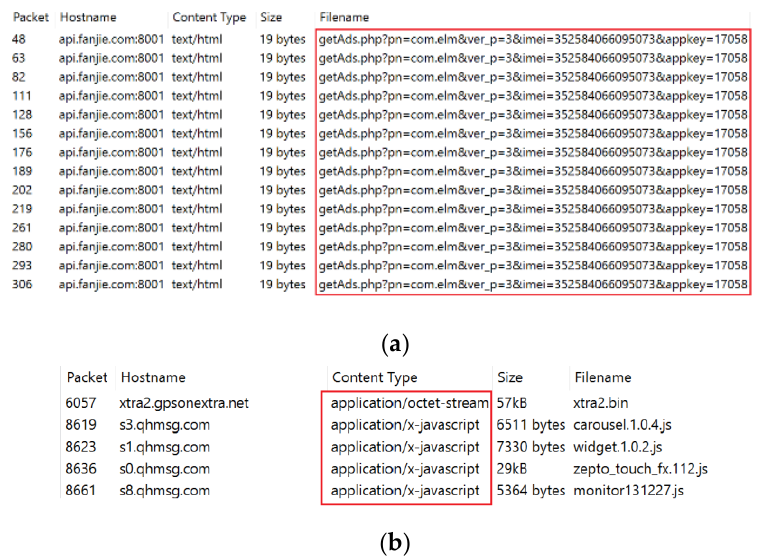
Figure 1. Malicious behaviors of adware and riskware network traffic. ( a ) Adware, ( b ) riskware.